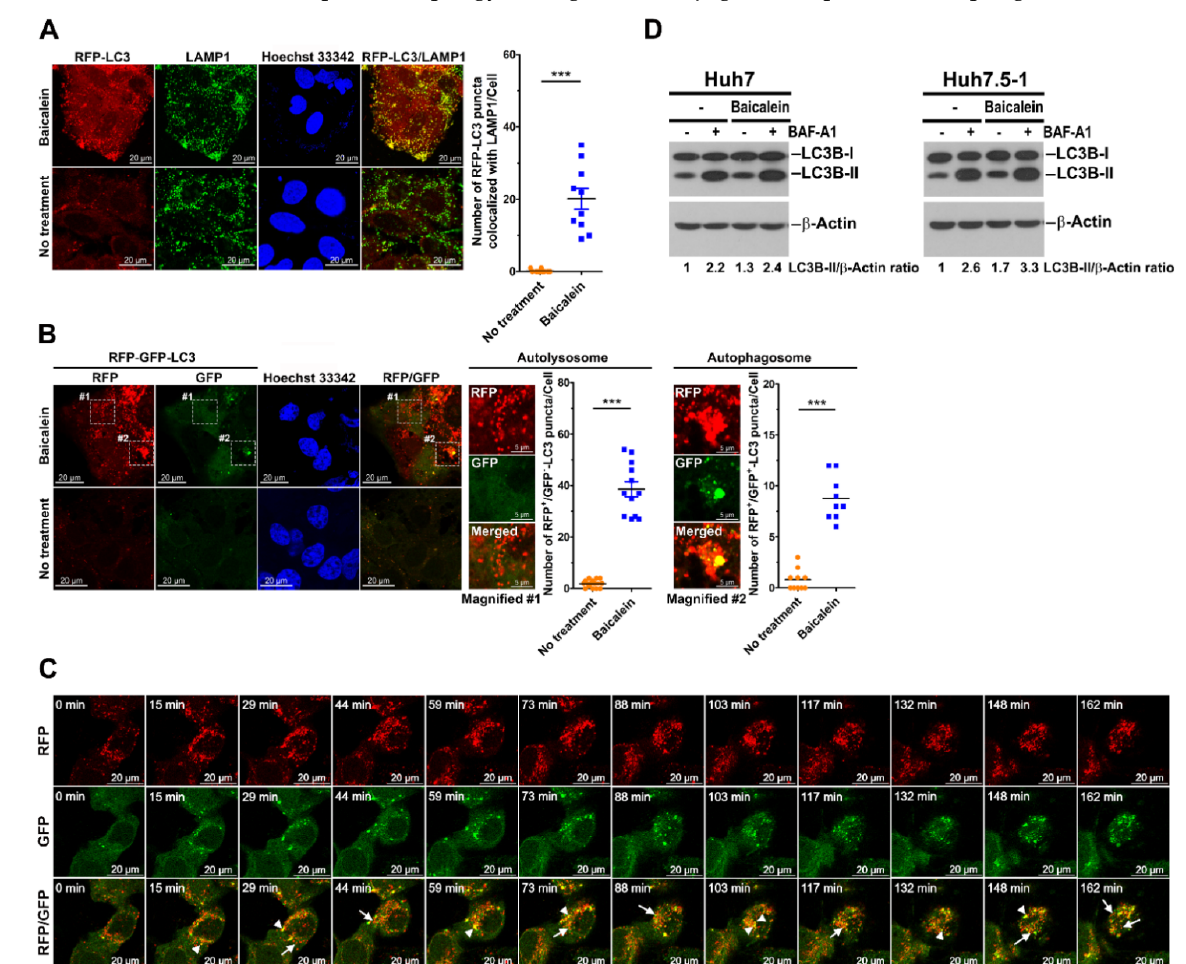
Figure 2. Activation of complete autophagy by baicalein: ( A ) Huh7/RFP-LC3 cells were treated with or without 0.5 mM baicalein. Four hours later, the cells were fixed and immunostained with LAMP1 (green) and Hoechst 33342 (blue). The number of RFP-LC3 puncta colocalized with LAMP1 was quantified. The data represent the means ± SEM ( n = 10, *** p < 0.001). ( B ) Huh7 cells stably expressing RFP-GFP-LC3 (Huh7/RFP-GFP-LC3 cells) were established by lentiviral gene delivery as described in the “Materials and Methods” and then cultured in the presence or absence of 0.5 mM baicalein for four hours. Then, the cells were fixed and stained with Hoechst 33342 for nuclear identification. RFP + /GFP − puncta (autolysosome) and RFP + /GFP + puncta (autophagosome) are indicated in magnified field-1 and magnified field-2, respectively. White dashed boxes 1 and 2 show the areas of baicalein-treated cells at a higher magnification. The numbers of autophagosomes and autolysosomes were quantified, and the data represent the means ± SEM ( n = 10, *** p < 0.001). ( C ) Selected live imaging frames showing 0.5 mM baicalein-treated Huh7/RFP-GFP-LC3 cells. The full-length video showing the live imaging is presented in Supplemental Video S3. The white arrowheads and arrows in a representative image indicate the formation of RFP + /GFP + autophagosomes and RFP + /GFP − autolysosomes, respectively. ( D ) Huh7 and Huh7.5 cells were cultured in the presence or absence of 0.2 mM baicalein for six hours. Then, the baicalein-treated cells and untreated cells were treated without ( − ) and with (+) 50 nM BAF-A1. Three hours later, the cells were harvested, and protein expression was analyzed by Western blotting. The relative expression ratio of LC3B-II to β -actin was determined by gel densitometry using ImageJ.